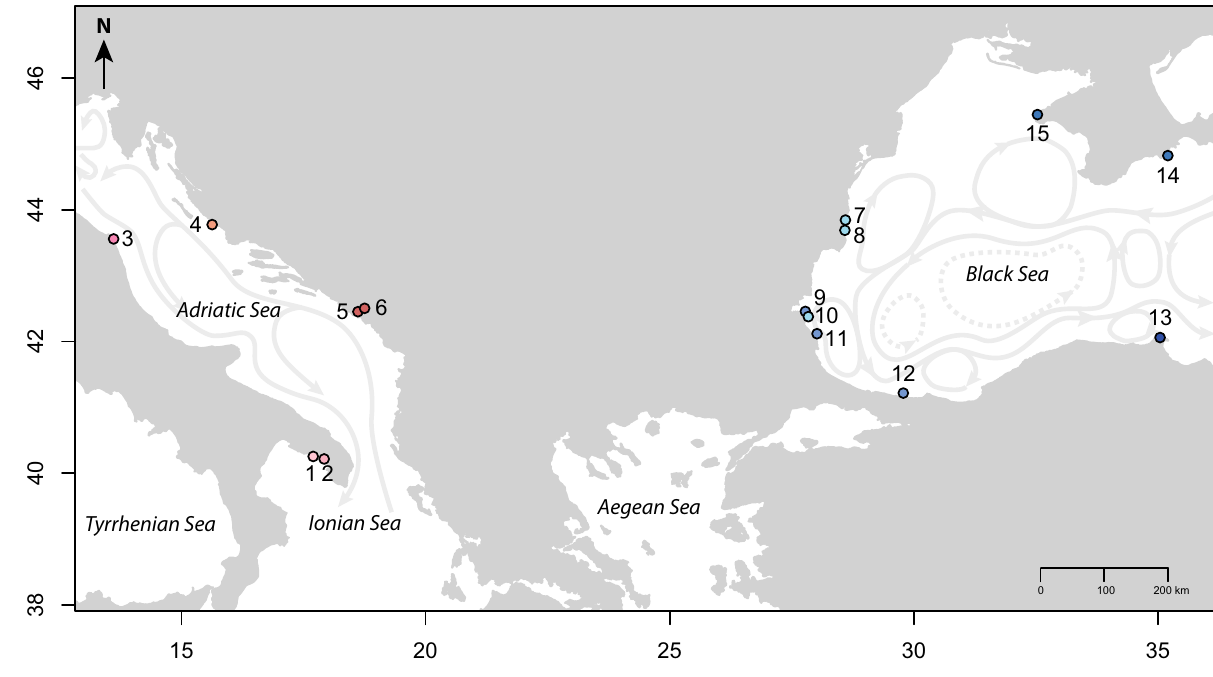
Figure 1. Sampling locations of Gongolaria barbata and the global Sea surface circulation (grey arrows). Each study site is labeled as follow: (A) in the Ionian Sea: 1—Porto Cesareo—Isola Scoglio (Italy), 2—Porto Cesareo (Italy), (B) in the Adriatic Sea: 3—Conero (Italy), 4—Kornati (Croatia), 5- and 6—Boka Kotorska (Montenegro), and (C) in the Black Sea: 7—Costinesti (Romania), 8—Kaliakra (Bulgaria), 9–11—Ropotamo Kiten (Bulgaria), 12—Sile (Turkey), 13—Sinop (Turkey), 14—Karadagand (Ukraine) and 15—Tarhankut (Ukraine). GPS coordinates are provided in Table 1. The map was created using the R package mapdata 105–107